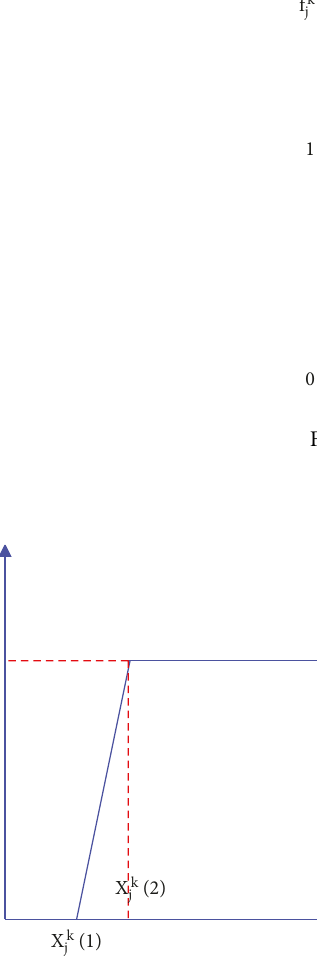
Figure 7: Schematic diagram of the upper limit measurement type.